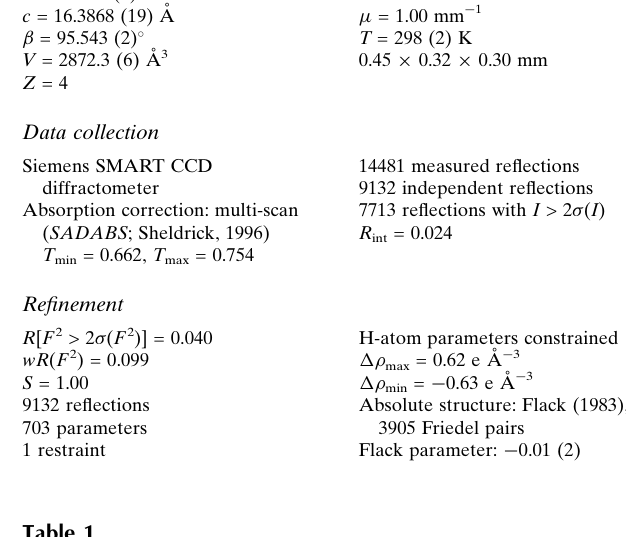
Hydrogen-bond geometry (A˚ , (cid:2)